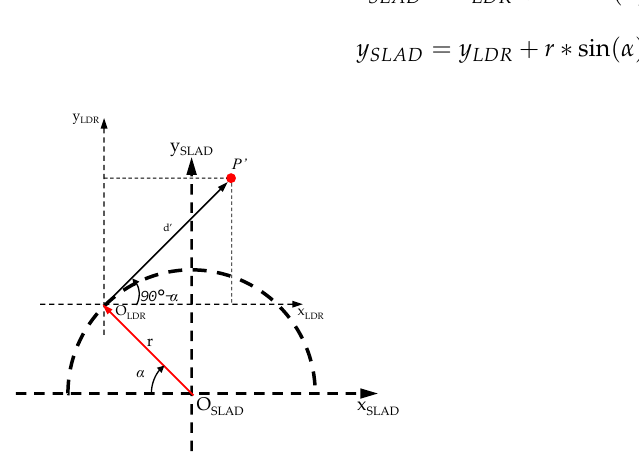
Figure 13. Coordinate frames.